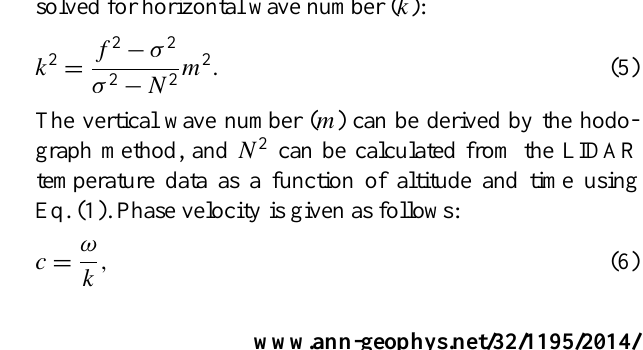
speed became lower after 21:00 UT above 90 km, and the wind direction changed from north to south around 21:30 UT below ∼ 90